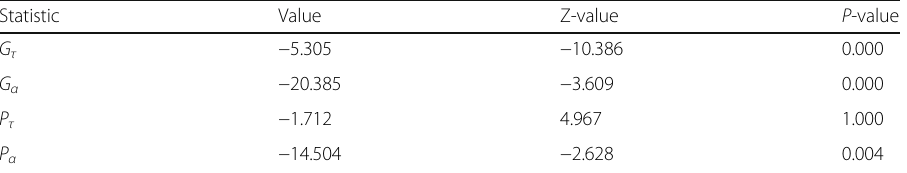
Table 4 Panel Asymptotic Cointegration Test (Excluding Indonesia And Brunei) Statistic Value Z-value P -value G τ −